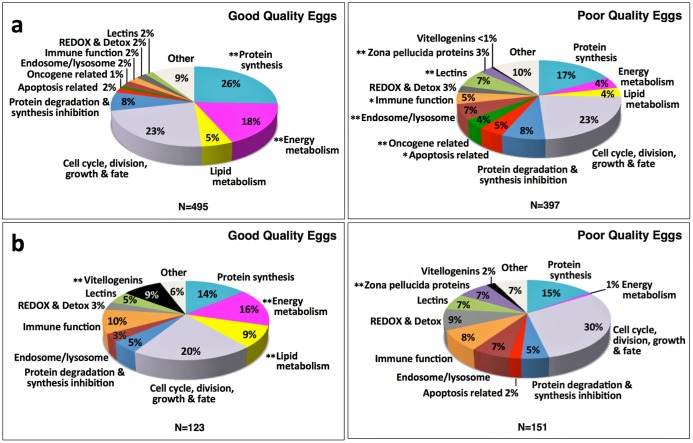
Distribution of proteins up-regulated in good and poor quality zebrafish eggs among functional categories.Panel a. Pooled Samples Experiment. Panel b. Multiple Samples Experiment. Only proteins common to both egg quality types with a ≥2-fold difference in N-SC between egg quality types, or proteins unique to an egg quality type, were considered to be up-regulated for these analyses. In both experiments, the overall distribution of up-regulated proteins among functional categories significantly differed between egg quality types (χ2, p<0.0001). Double asterisks indicate protein categories whose proportional representation differed significantly between egg quality types (χ2, p≤0.05) after Benjamini Hochberg correction for multiple post-hoc tests. Single asterisks indicate other protein categories with p-values from the post-hoc χ2 analyses ≤0.05 before Benjamini Hochberg correction. Ensembl Protein IDs and associated gene, transcript and protein names, functional categories, type of regulation (unique or up-regulated), and fold-difference between egg quality types in common protein N-SC values are given in S1 Table (Pooled Samples Experiment) and S2 Table (Multiple Samples Experiment).